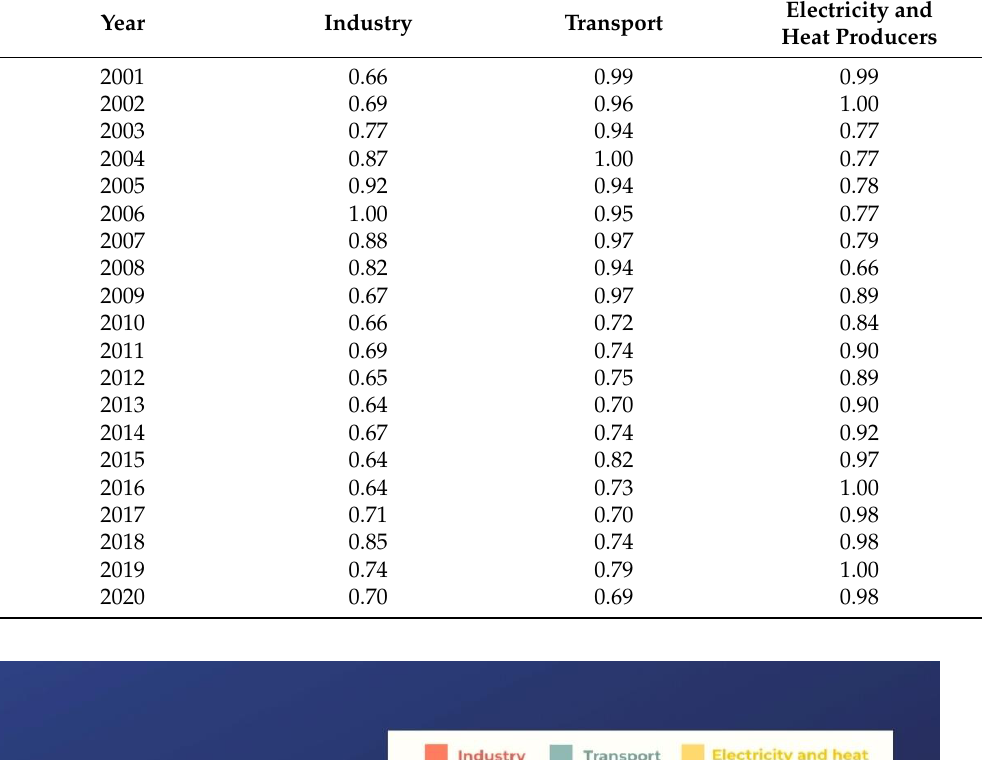
Table 2. Sector efficiency scores.